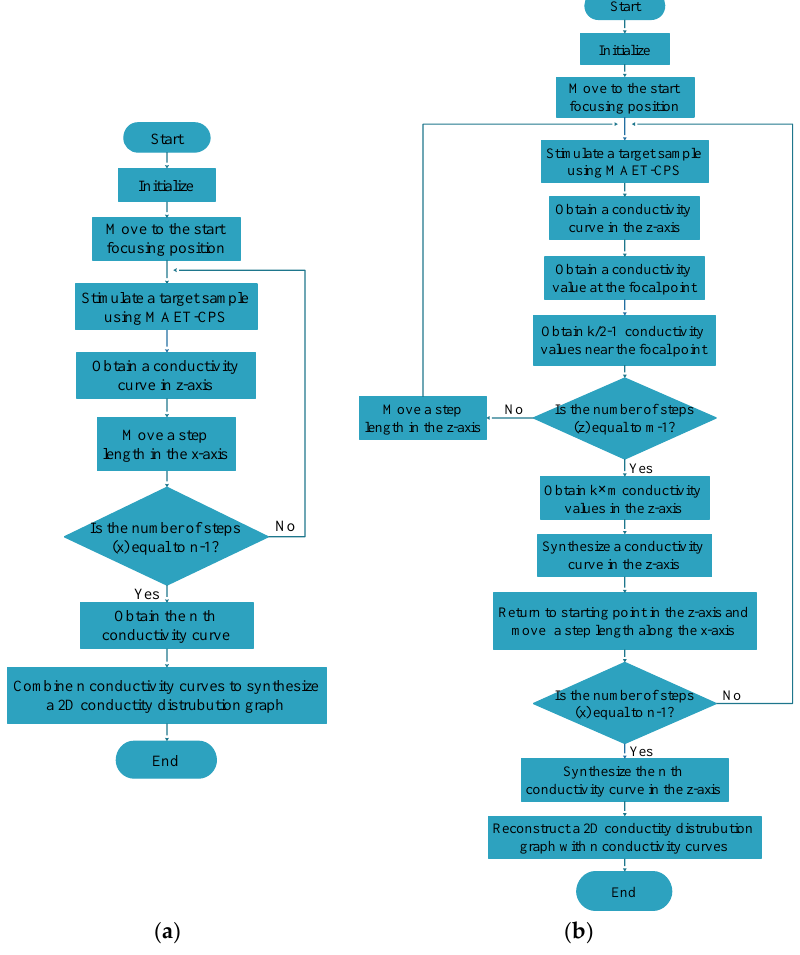
Figure 8. The motion control and image synthesis processes: ( a ) the sfMAET-CPS; and ( b ) the mfMAET-CPS.